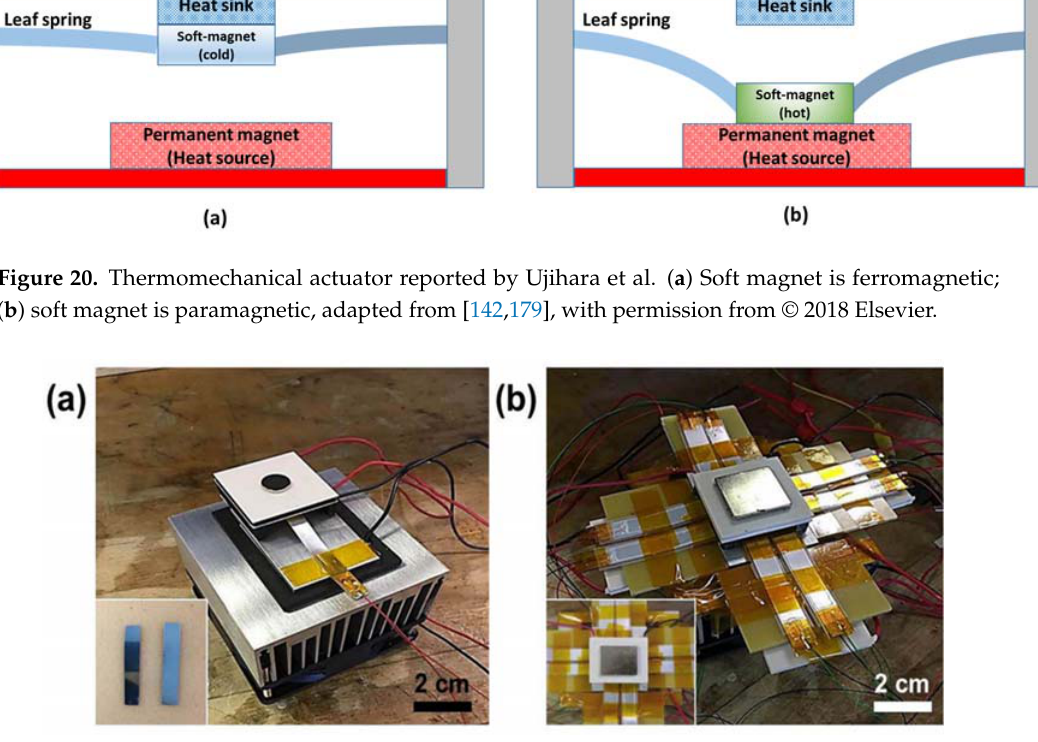
Figure 21. Chun et al.’s thermo-magneto-electric generator (TMEG). ( a ) TMEG with a single bimorph cantilever and ( b ) TMEG with arrays of bimorph cantilevers. Figure taken from [180].